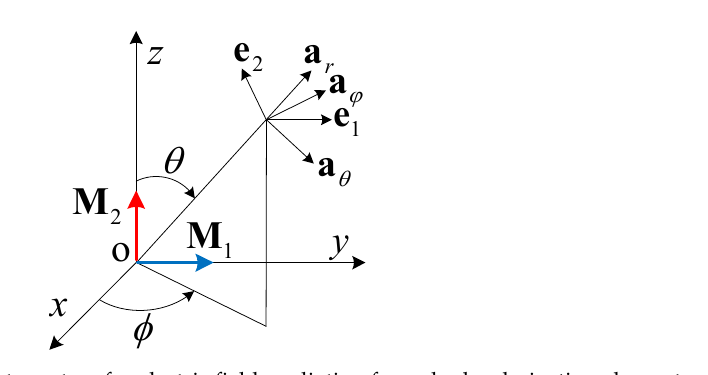
Figure 1. Spherical coordinate system for electric fields radiating from dual-polarization